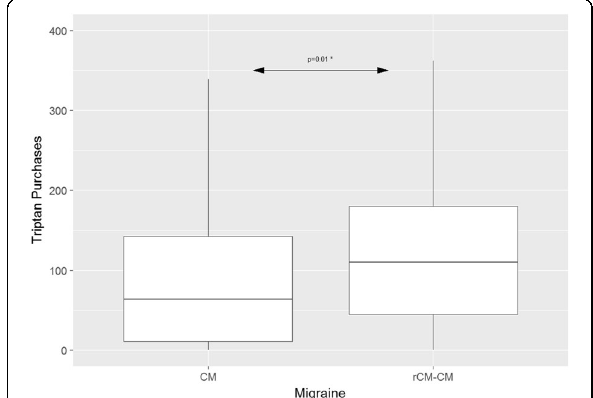
Fig. 1 (abstract P147). Distribution of triptan purchases. pCM: proposed chronic migraine, CM: chronic migraine